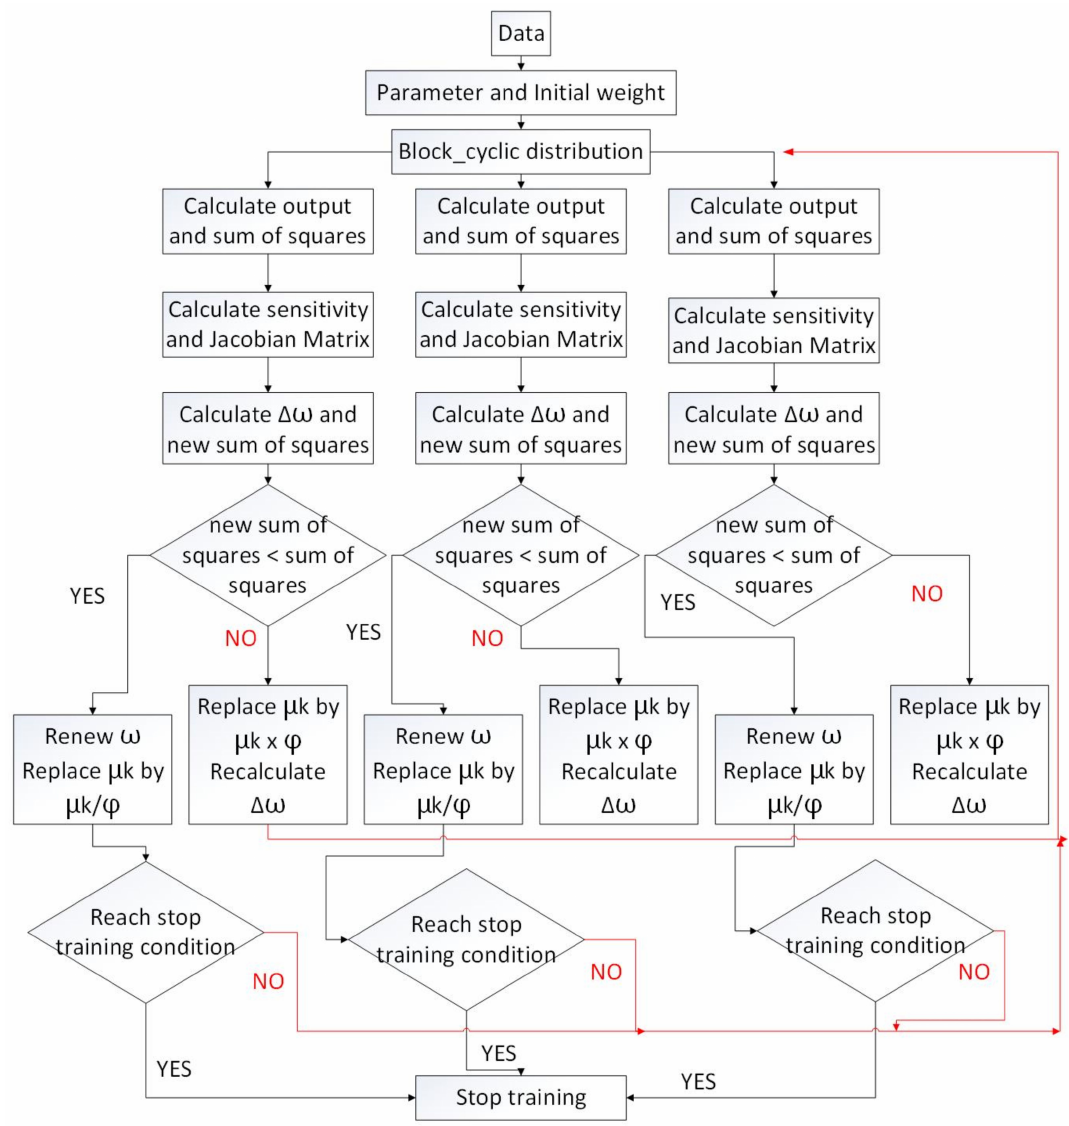
Figure 16. Flowchart of